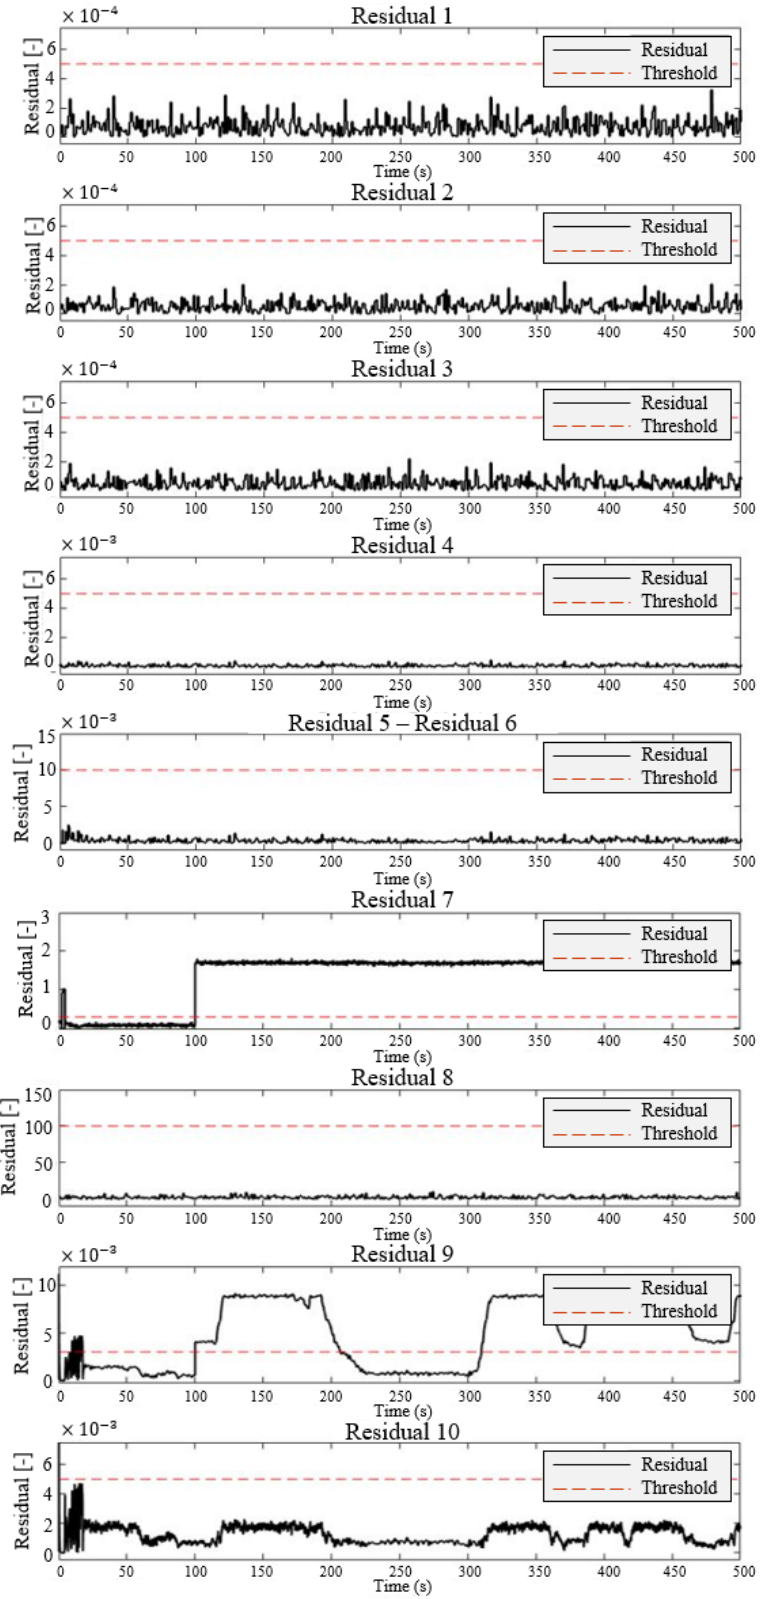
Figure 10. Residuals in case of air pressure sensor fault.